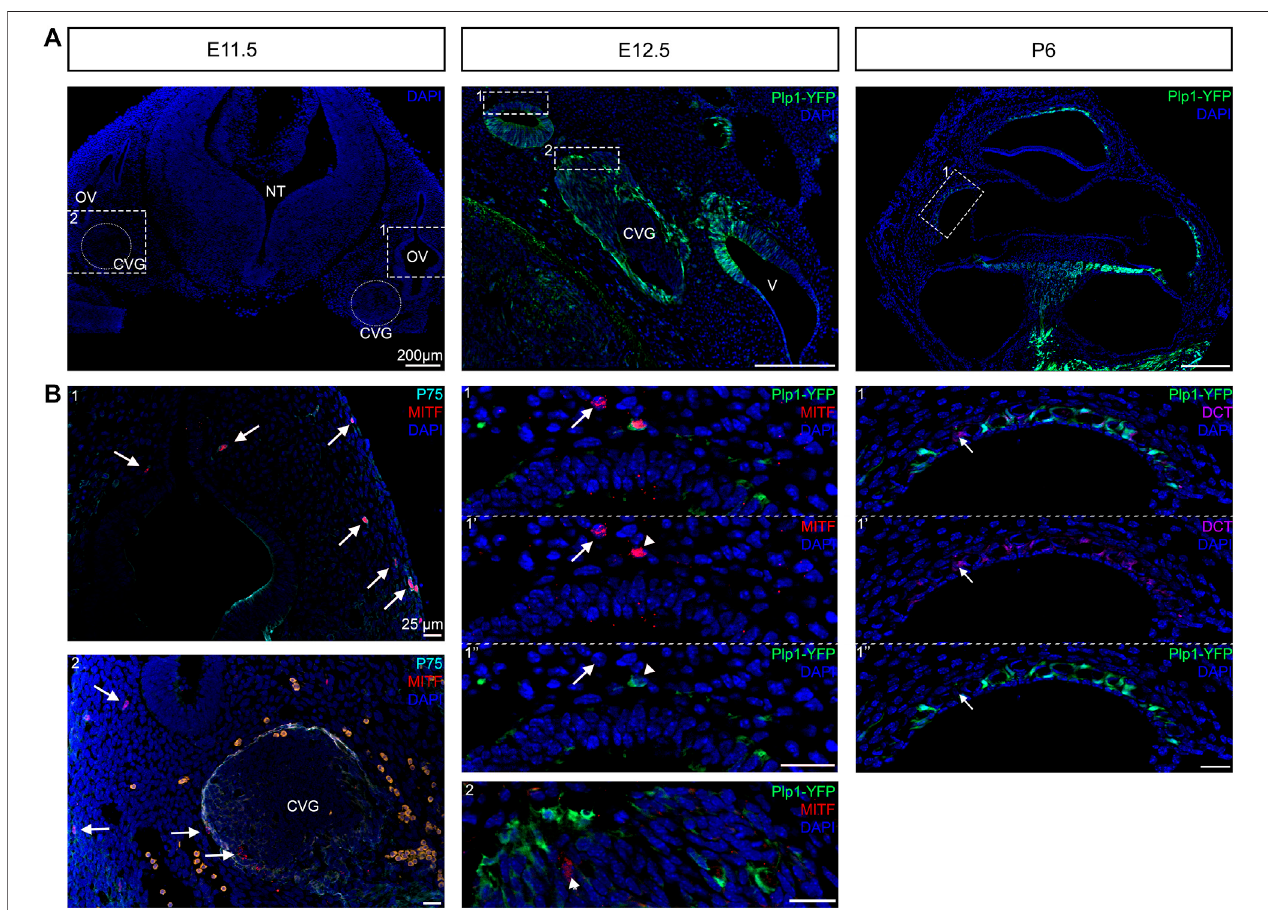
FIGURE 4 | Dual embryonic origin of intermediate cells. Immunostaining for melanoblast with MITF labelling (in red) and neural crest cells with P75 (in turquoise) shows at E11.5 the presence of melanoblast between the dermis and the otic vesicle and between the otic vesicle and the neural tube (Arrows). Lineage tracing of Schwann cell precursors using Plp1-YFP reporter line at E12.5 and P6. Immunostaining for melanoblast with the MITF antibody (red) and DAPI for nucleus (blue) show cellswithbothmarkers(arrowheads)oronlymelanoblastmarker(arrows).MostintermediatecellsexpresstheglialcellmarkerPLP(green)andmelanocytemarkers DCT (in purple) at P6 except one cell that only express DCT (arrow). CVG: cochleaovestibular ganglion, NT: neural tube, OV: otic vesicle, V: